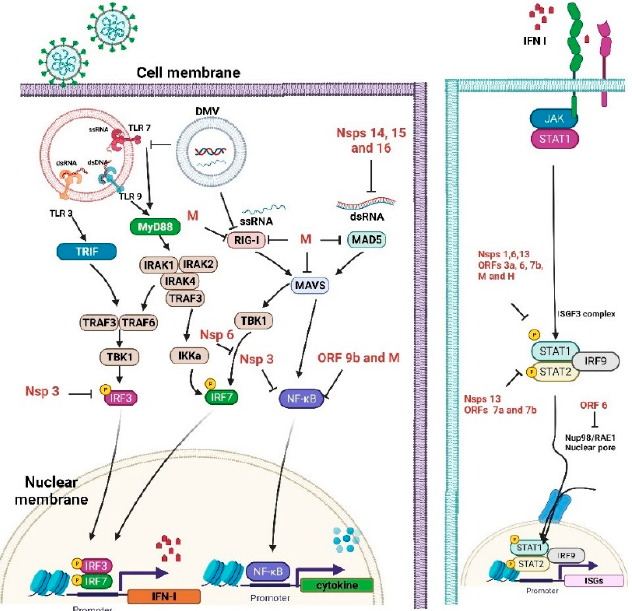
Figure 1. Immune evasion by severe acute respiratory syndrome coronavirus 2 (SARS-CoV-2). Unlike TLRs, which act as endosomal sensors, RLRs have been extensively studied as cytosolic dsRNA virus sensors to mediate IFN transcription and activate mitochondrial antiviral-signaling (MAVS) proteins [48]. Upon viral infection, RIG-I interacts with MAVS proteins to activate latent NF- κ B and interferon regulatory factors (IRF)3/7, subsequently inducing proinflammatory cytokine production